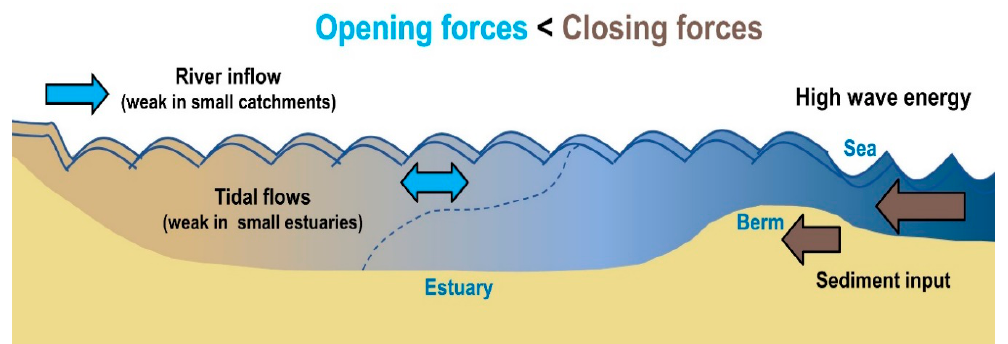
Figure 1 . Longitudinal representation of a temporarily closed estuary showing the main opening and closing forces that influence mouth condition.